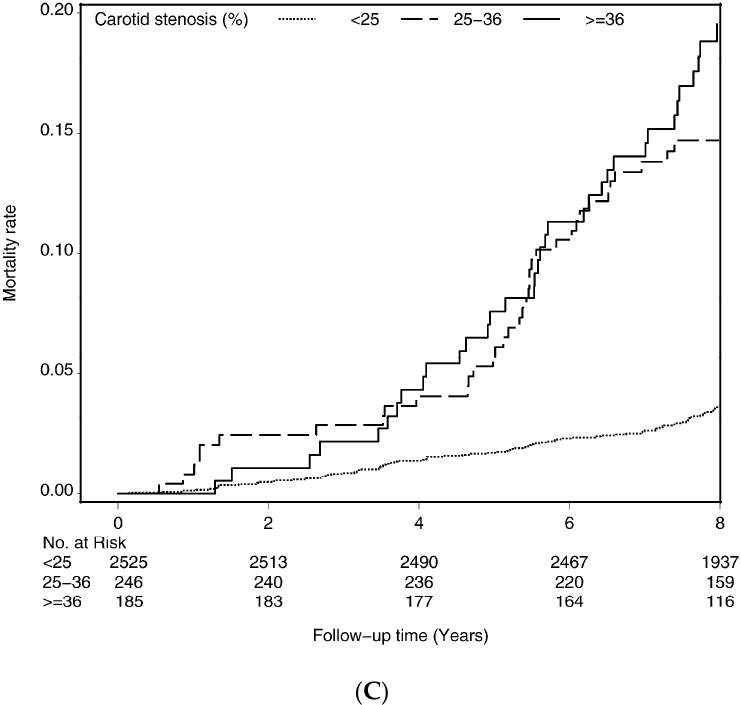
Figure 1. Survival curves of death for ( A ) intima–media thickness, ( B ) carotid plaque, and ( C ) carotid stenosis.